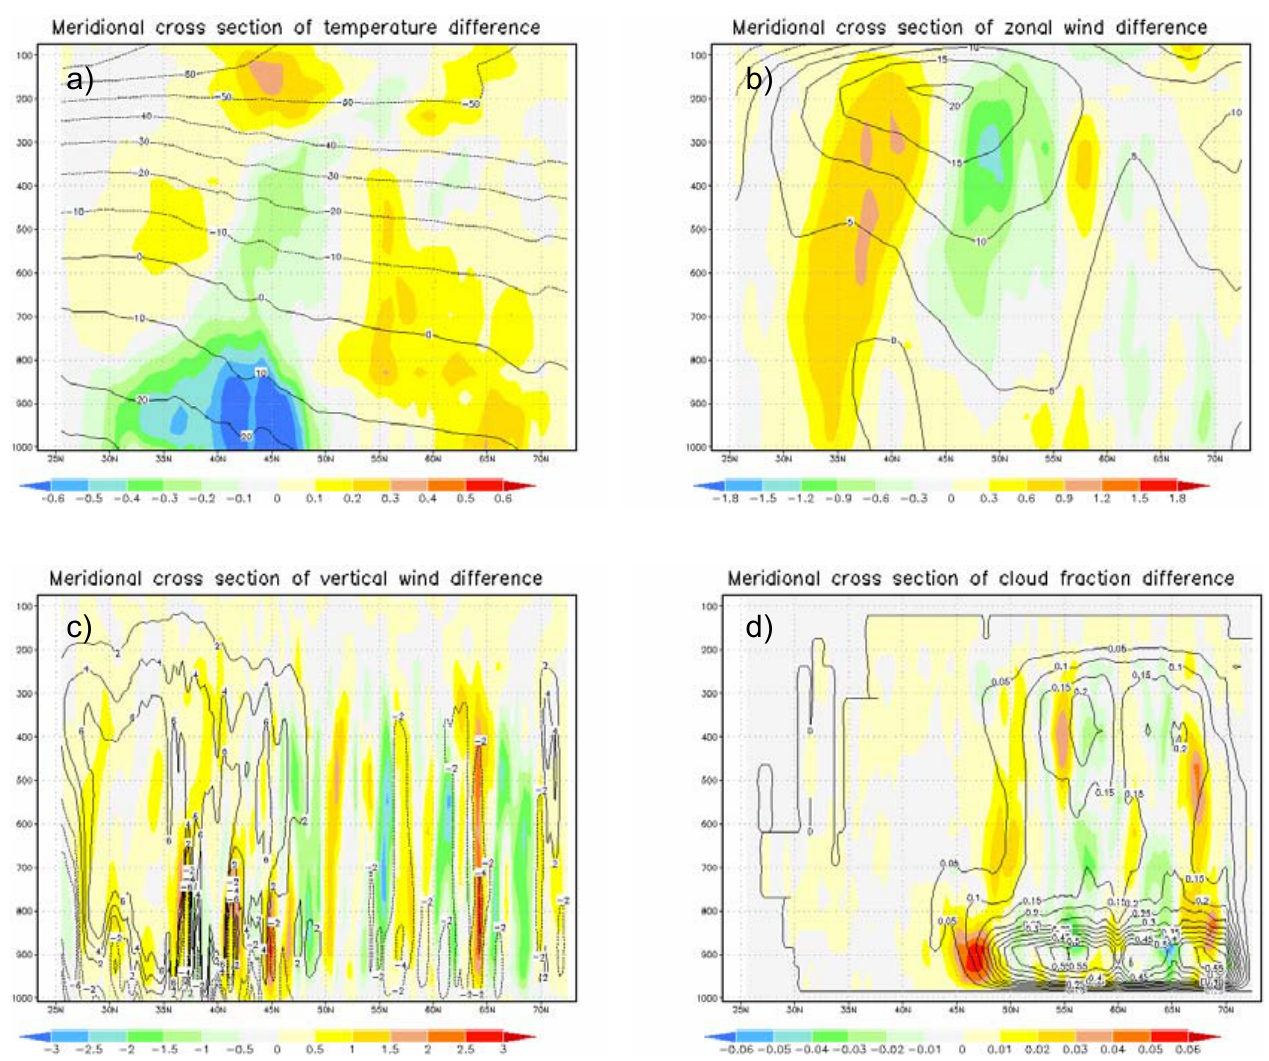
Figure 7. Mean summer (for the year 2000) meridional cross sections averaged over the longitudinal zone 20 o E-30 o E of the difference AFrun-Crun RegCM3/aerosol simulations due to aerosol feedback in a) air temperature ( o C), b) zonal wind (m/s), c) vertical wind (10 -5 hPa/s) and d) cloud fraction (dimensionless). The respective mean summer meridional cross sections of air temperature, zonal, meridional and vertical wind in the control simulation (Crun) are superimposed with black contours.